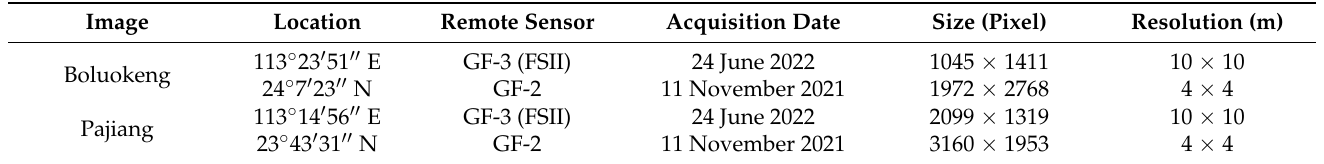
Table 1. Summary of remote sensing data used in this study. Image Location Remote